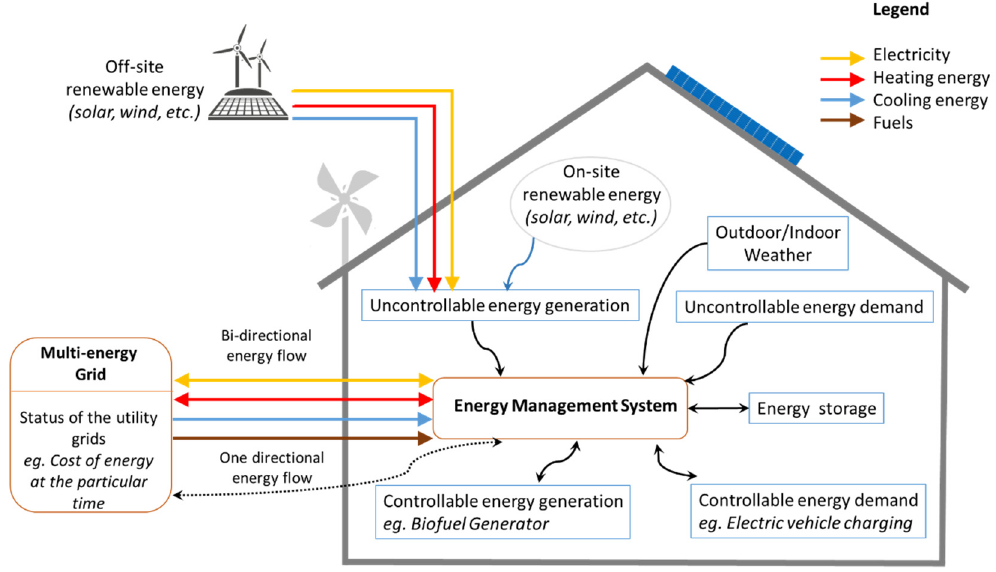
Figure 5. Smart energy management schema of PEBs. Partially reprinted with the permission from [46].